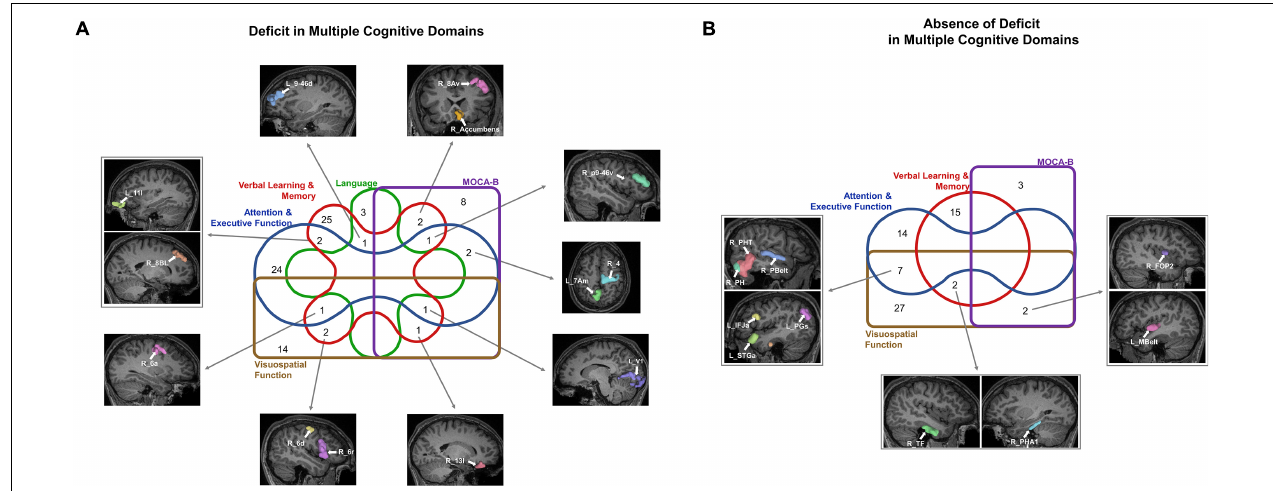
FIGURE 5 | Commonalities across cognitive domains may provide potential targets for screening, diagnosis, and treatment. The Venn diagrams show the parcels which are predictors of (A) deficit and (B) absence of deficit across at least two cognitive domains.